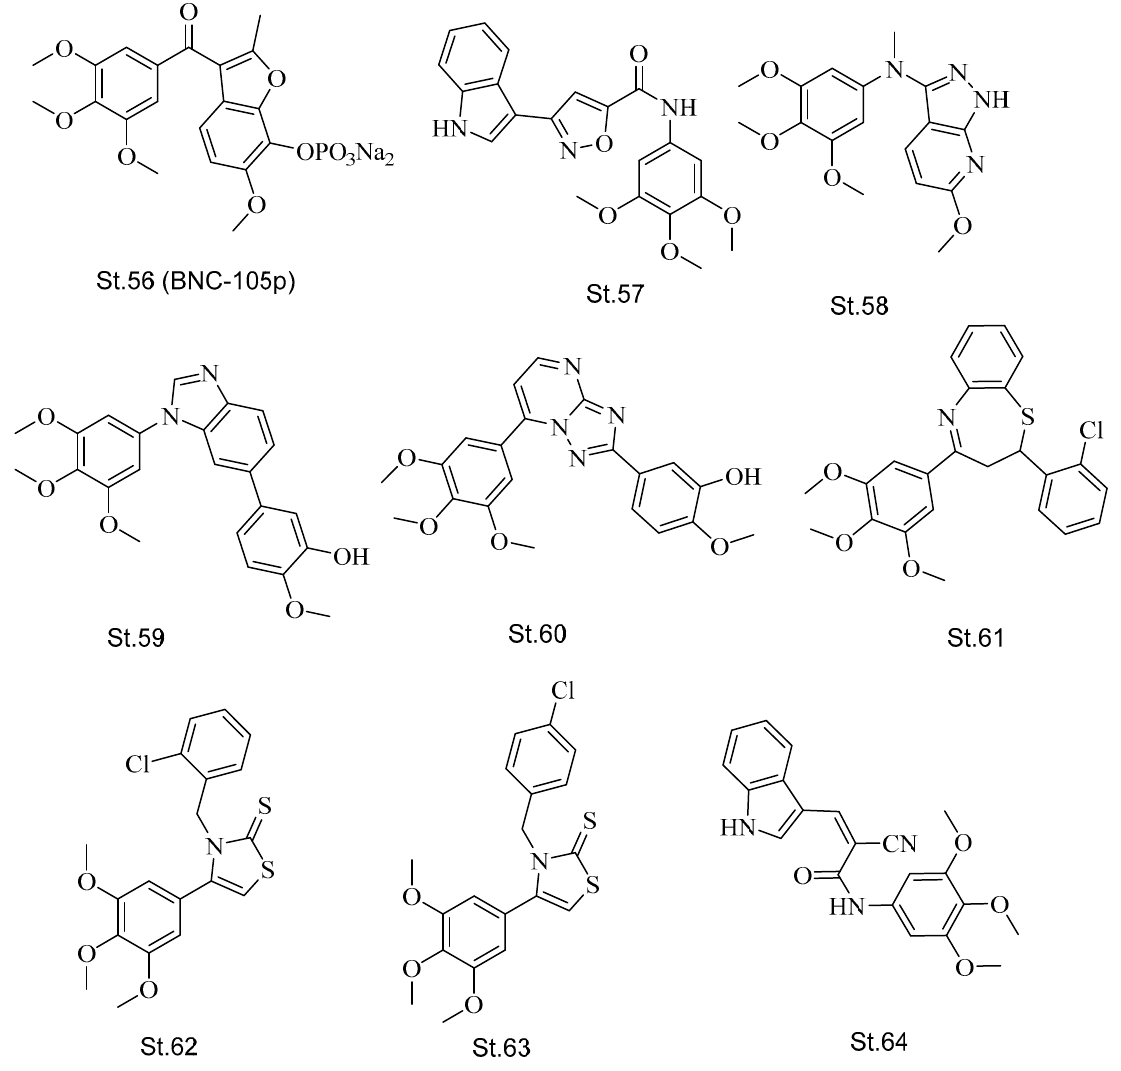
Figure 11. The structures of trimethoxyphenyl containing derivatives.